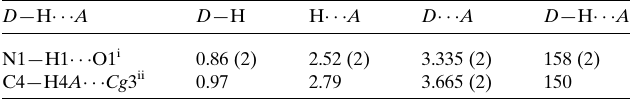
Table 1 Hydrogen-bond geometry (A˚ , (cid:2) ) for (I).